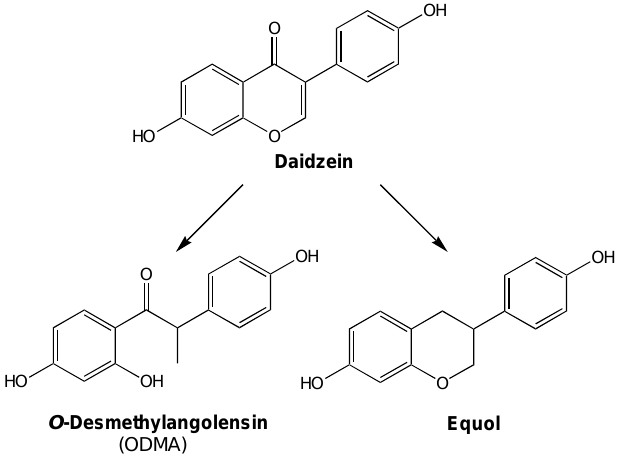
Figure 3. Possible metabolism products of